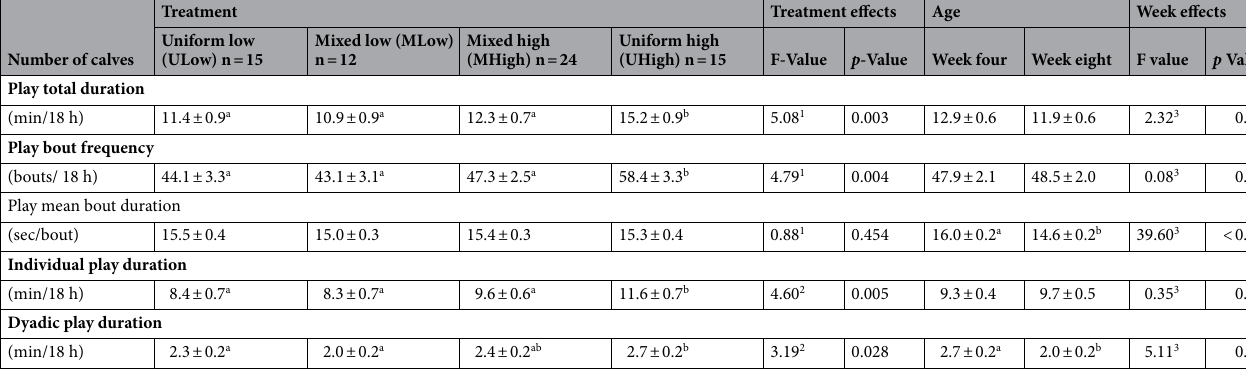
Table 2. Estimated least square means ± standard error (SE), F and p -values for treatments and age (weeks) from statistical analysis for all measured variables. Means within each row with different superscript letters differ at p < 0.05 in pairwise comparisons. 1 F 3,89 . 2 F 3,85 . 3 F 1,97 .